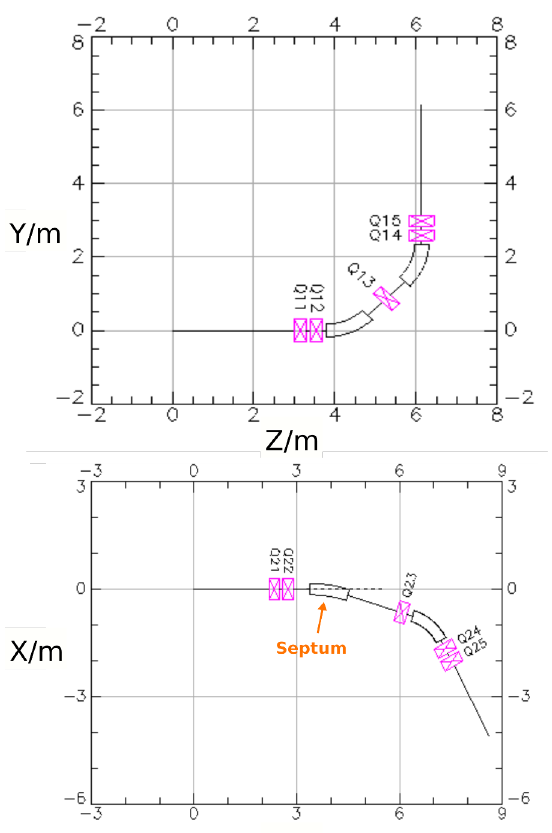
Figure 6. Floor plan of double-bend achromat unit used in seg- ment one and three (top) and the second segment (bottom) ac- cording to beam dynamics shown in figure 4 and figure 5, respec- tively, and as introduced in figure 3. The dashed line in the lower graph indicates the beamline for unperturbed proton pulses.